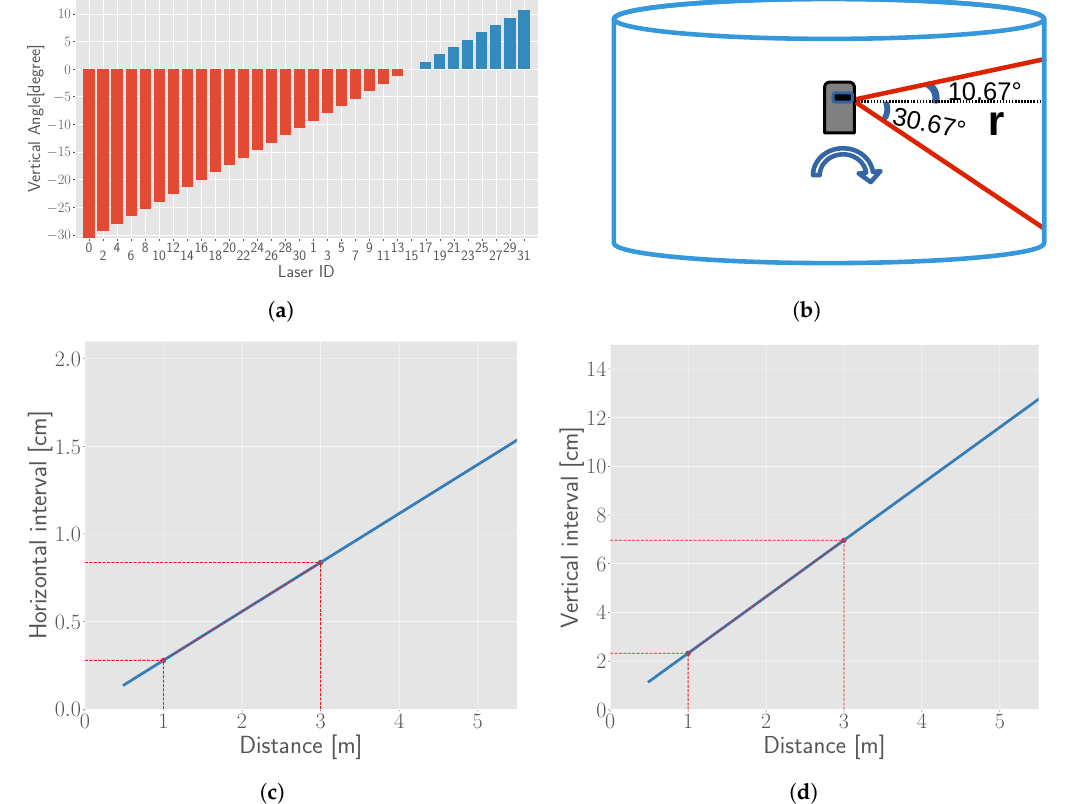
Figure 11. Vertical field view of Velodyne HDL-32e and the relationship between interval and distance. ( a ) Vertical angles of Velodyne HDL-32e; ( b ) Vertical field of view; ( c ) Relationship between the horizontal interval of two adjacent lasers and noise of the point cloud; ( d ) Relationship between the interval of two successive points of the scanline and the distance of the chessboard. Red lines in ( c , d ) show the range of chessboard’s distance we place in this